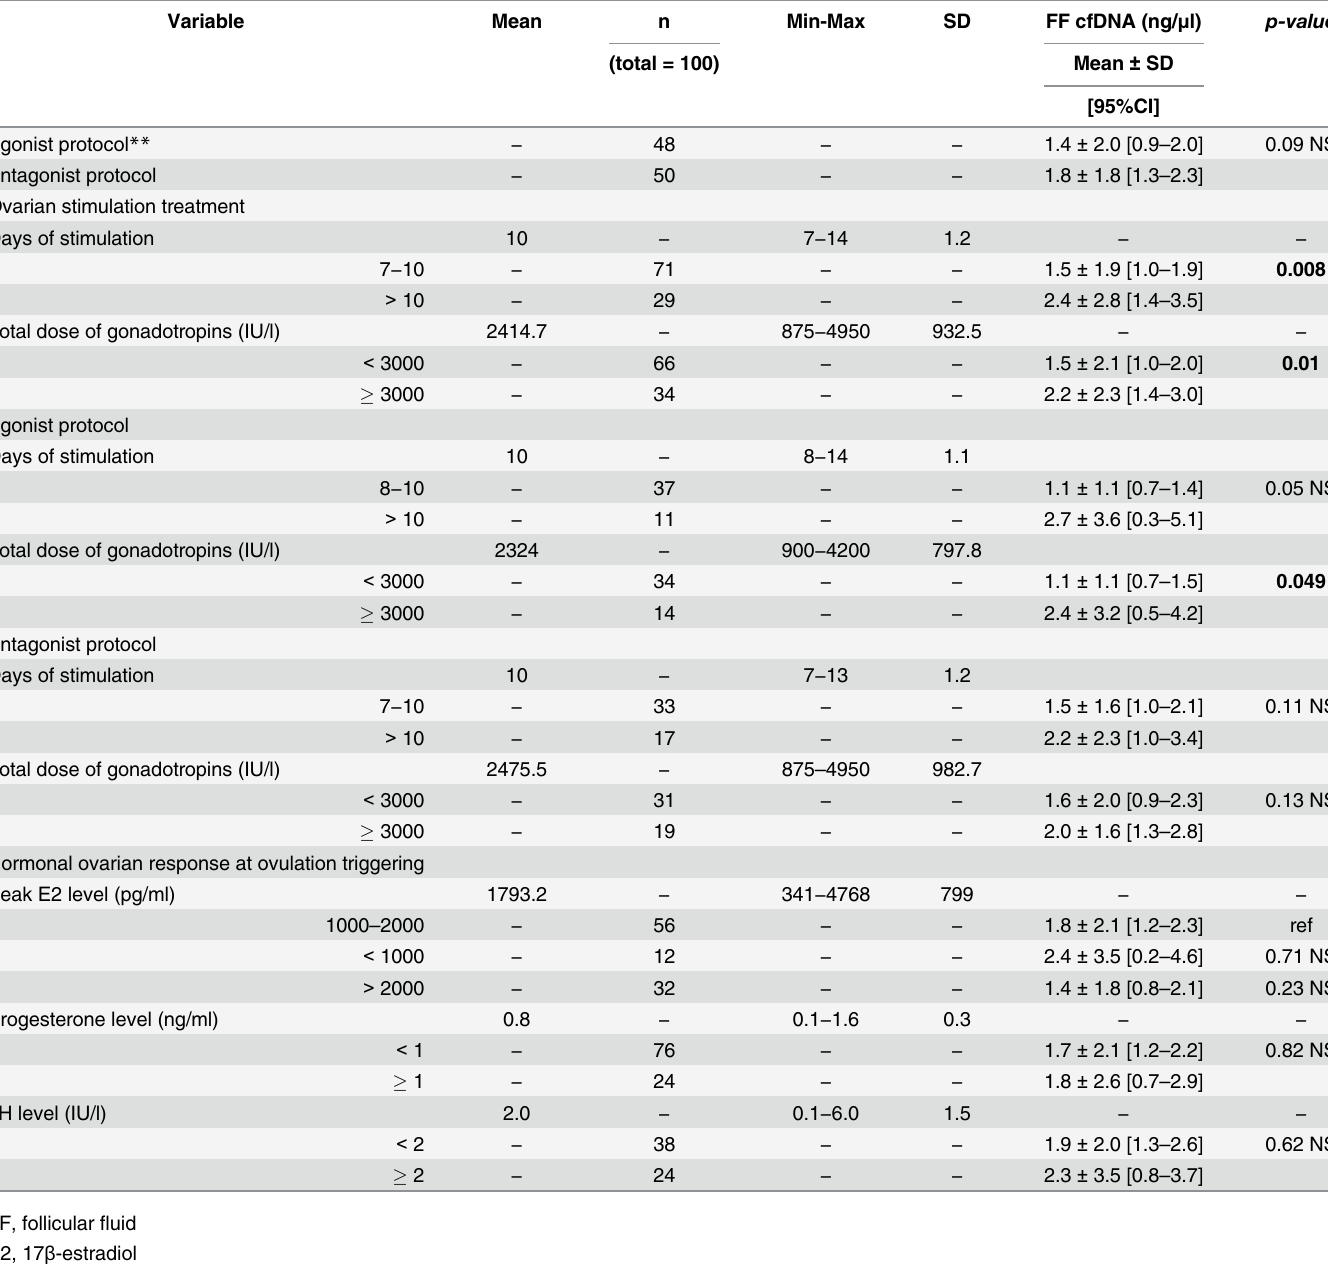
Table 2. Cell-free DNA level in follicular fluid pools according to controlled ovarian stimulation protocols and ovarian response to